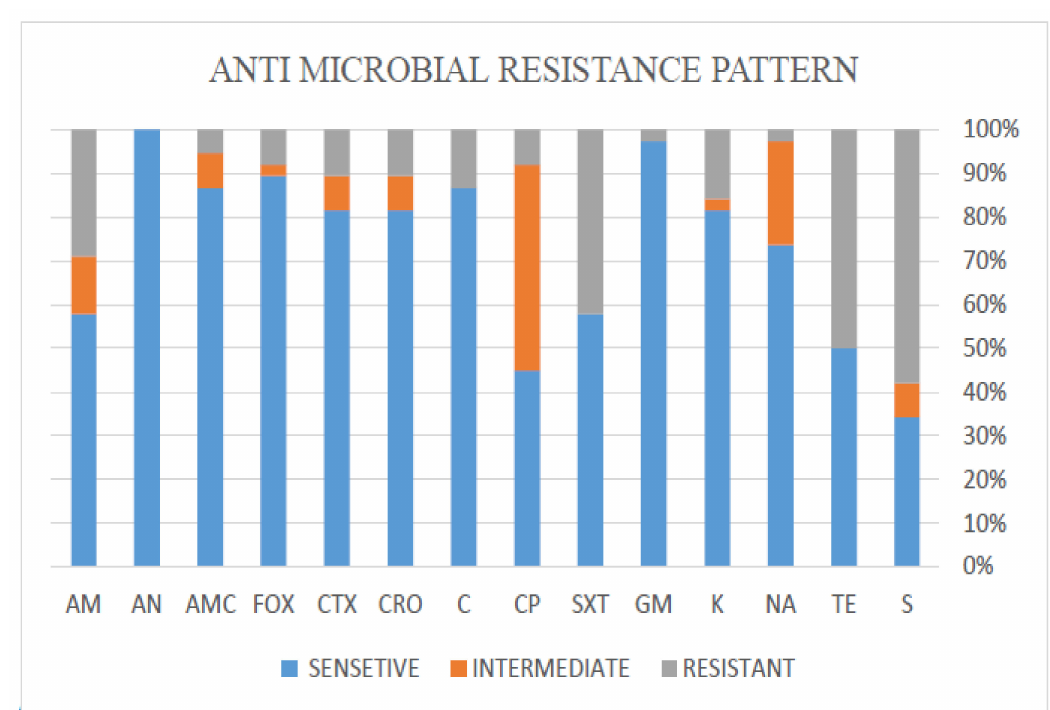
Figure 1. Antimicrobial resistance patterns of 38 E. coli strains isolated from traditional and pasteurized dairy products. AM: ampicillin, AN: amikacin, AMC: amoxicillin/clavulanic acid, FOX: cefoxitin, CTX: cefotaxime, CRO: ceftriaxone, C: chloramphenicol, CP: ciprofloxacin, SXT: trimethoprim/sulfamethoxazole, GM: gentamicin, K: kanamycin, NA: nalidixic acid, TE: tetracycline, S: